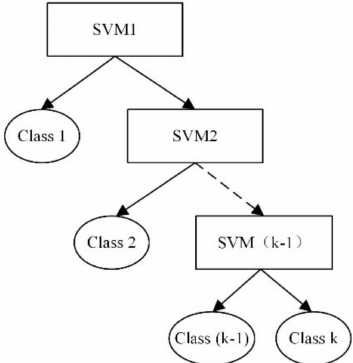
Figure 3. Illustration of the conventional Skewness Decision Tree Support Vector Machine